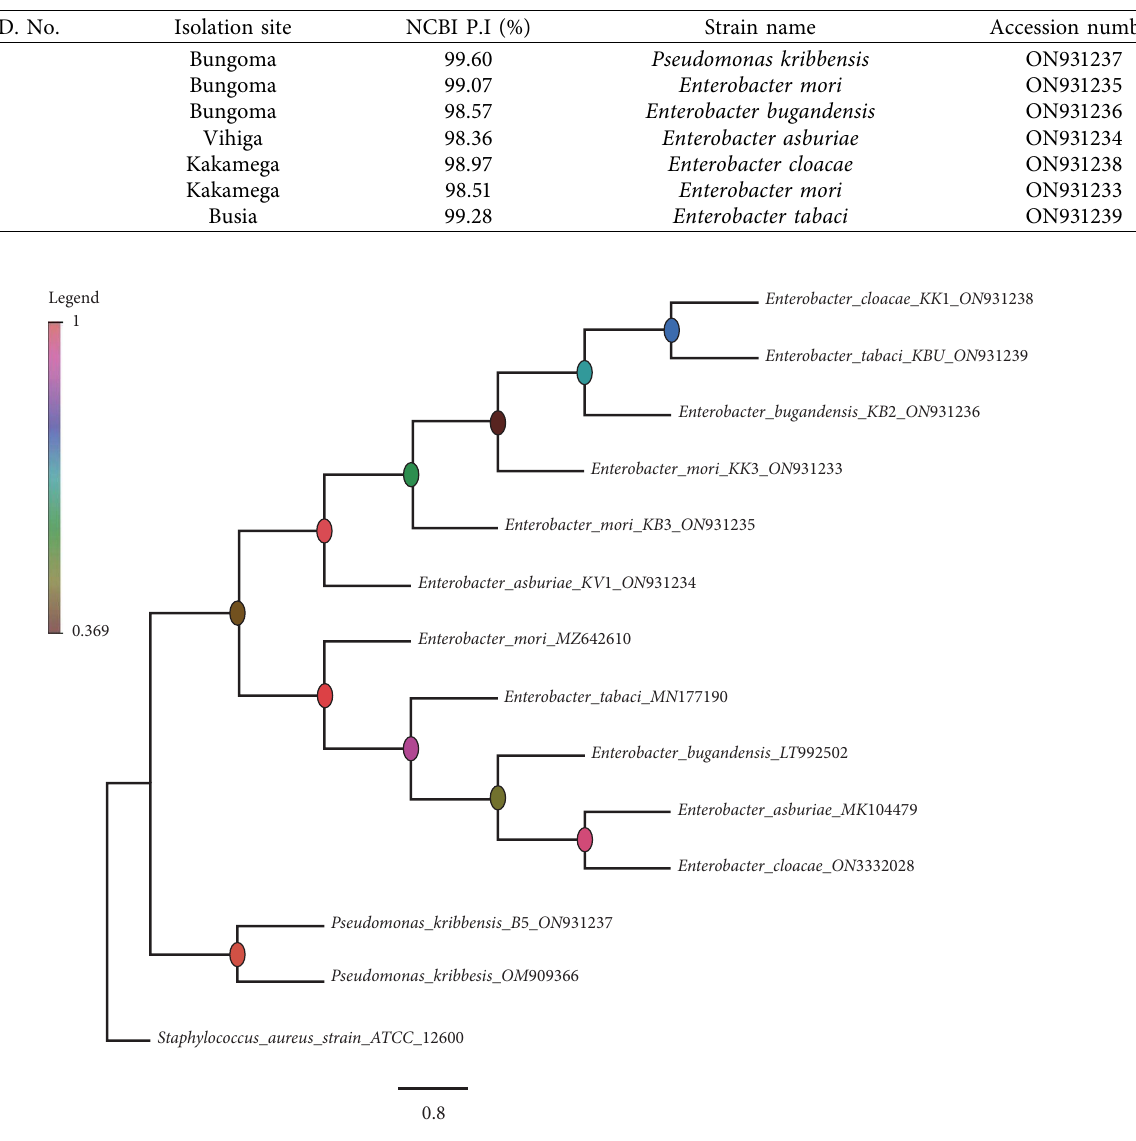
Figure 4: A tree showing phylogenetic relation between isolates with Staphylococcus _ aureus as an outgroup. Te nodes are colored per the legend in which the color corresponds to the approximate bootstrap support